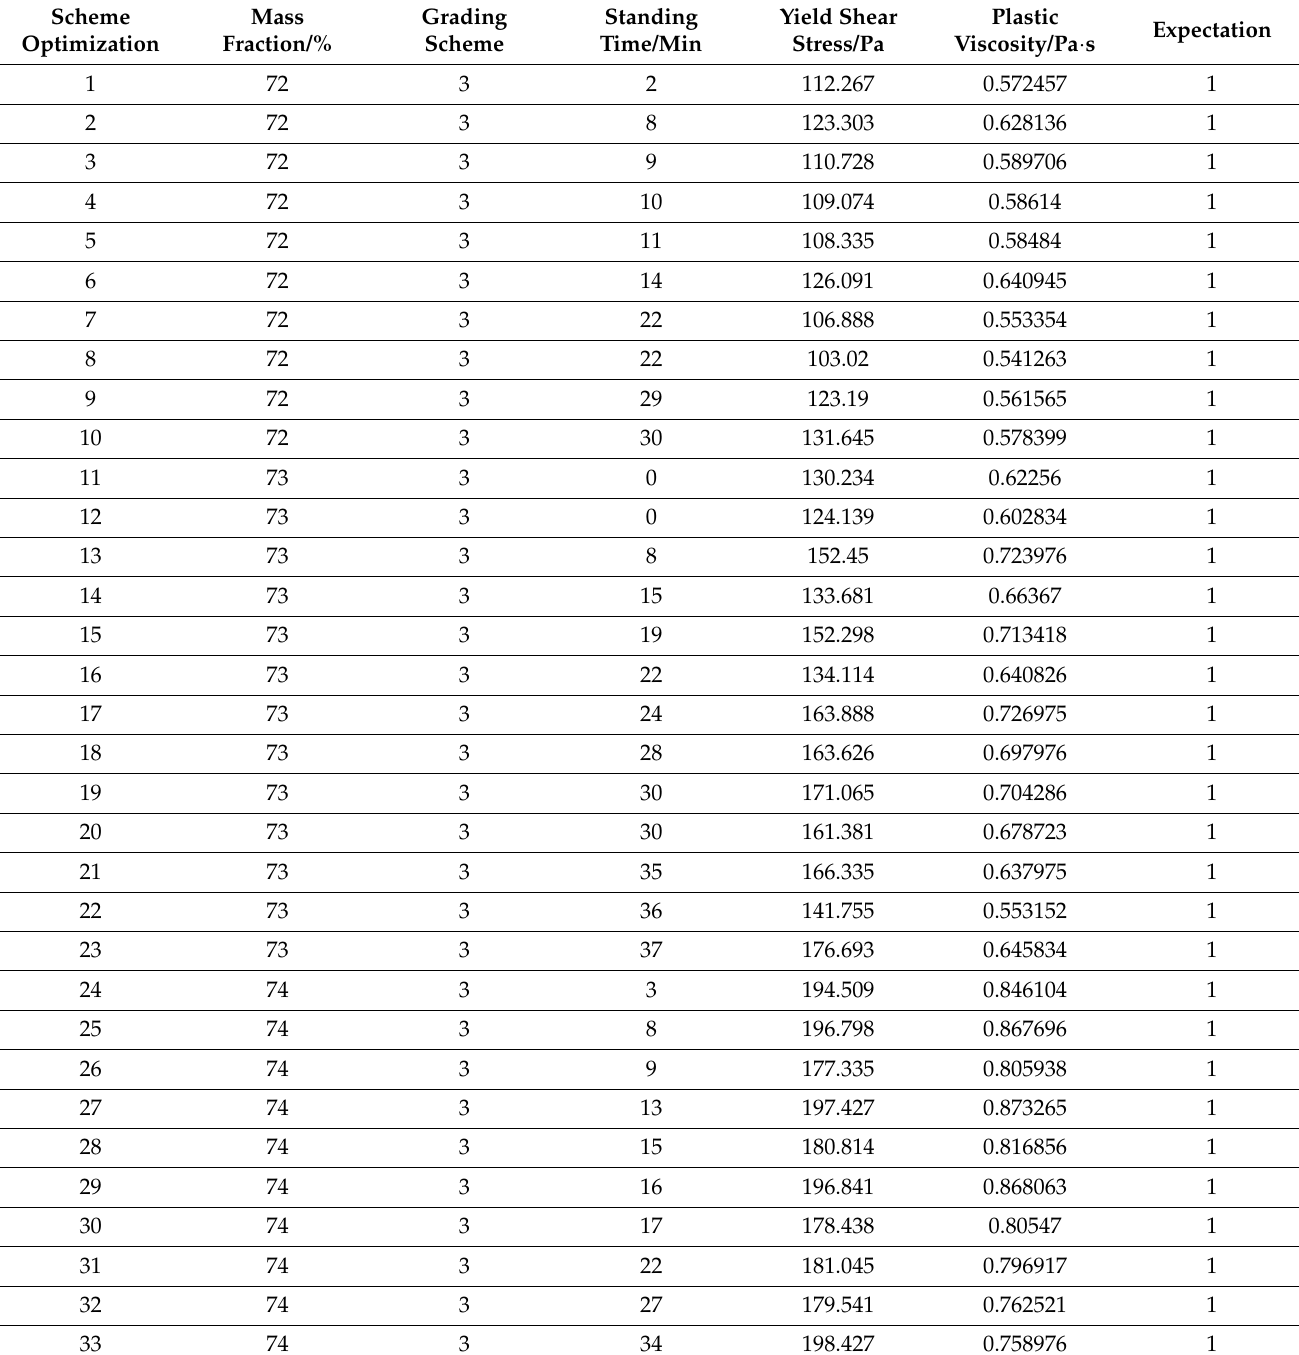
Table 15. Response surface optimization